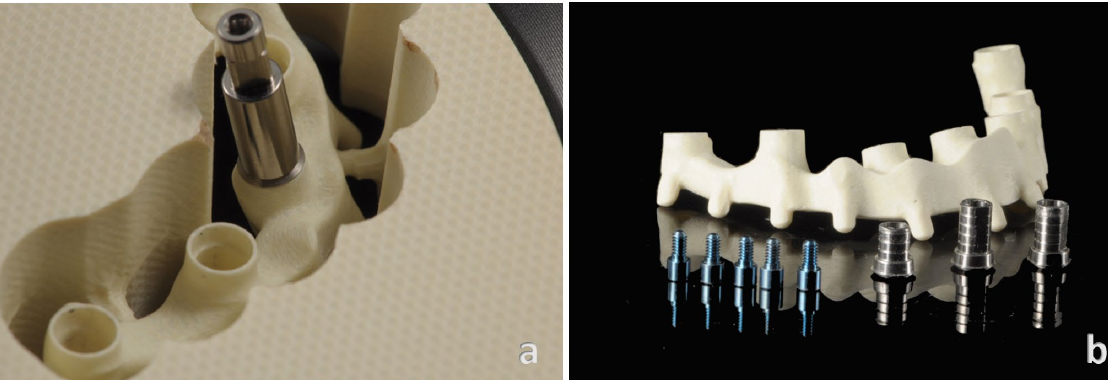
Figure 9. Provisional pre surgical prosthesis with esthetic characterization: palatal view ( a ), frontal view ( b ). Surgical phase planning: 1.